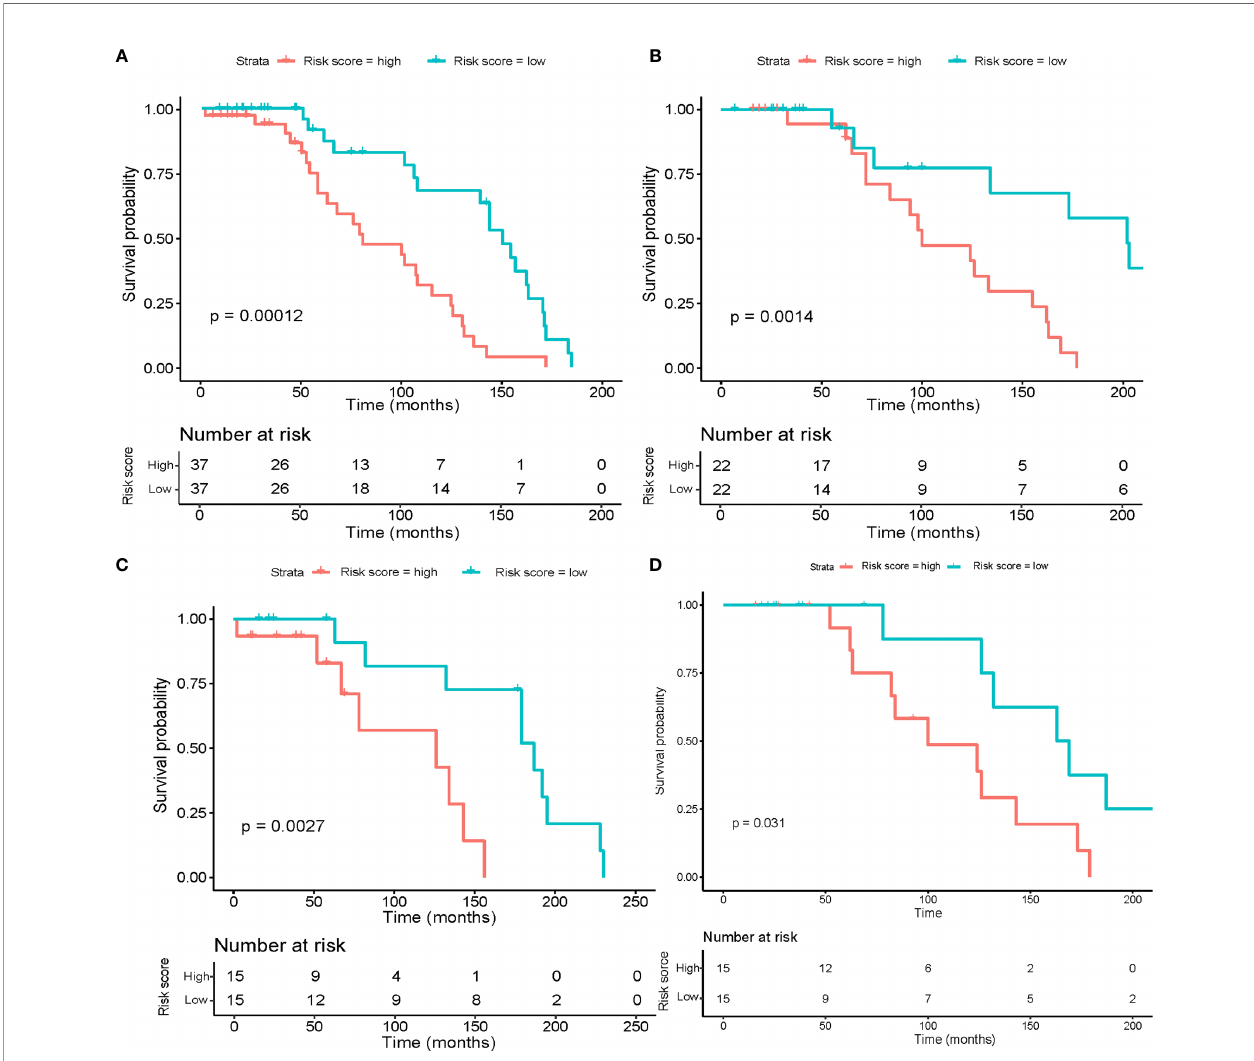
FIGURE 3 | Risk score calculated by the six tsRNA panel and Kaplan – Meier survival analysis results. The OS patients were separated into high-risk and low-risk groups using the median cutoff value. P-values were assessed using the log-rank test. (A) Kaplan – Meier survival analysis in the entire dataset. (B) Kaplan – Meier survival analysis in the training set. (C) Kaplan – Meier survival analysis in the internal validation set. (D) Kaplan – Meier survival analysis in the independent validation set.